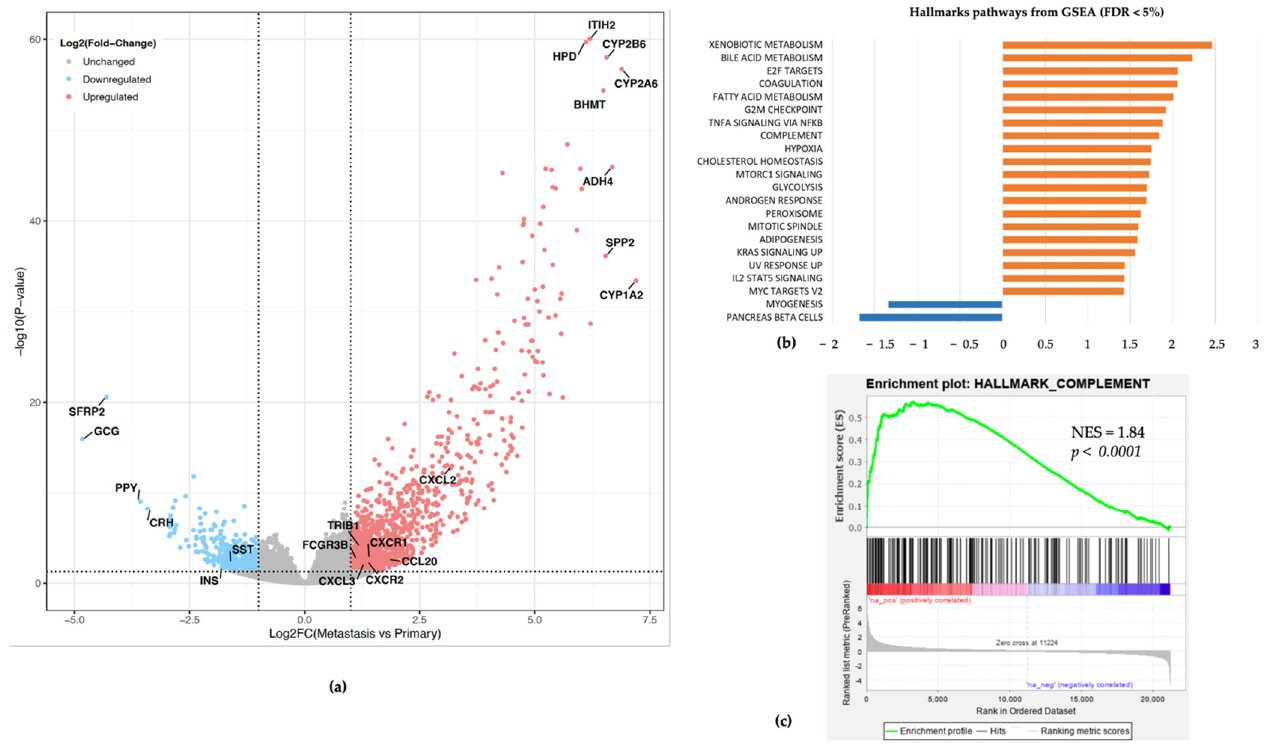
Figure 4. ( a ) Volcano plot of differential gene expression in liver metastasis versus primary pNET tumors. Each point represents a gene. Red represents upregulated genes, while blue is the downregulated one. ( b ) Bar plot representing differentially up- (orange) and down- (blue) regulated Hallmark pathways according to Gene Set Enrichment Analysis (GSEA analysis). NES: Normalized Enrichment Score. ( c ) Enrichment for complement pathway gene set in metastatic liver metastasis versus primary pNET tumors.